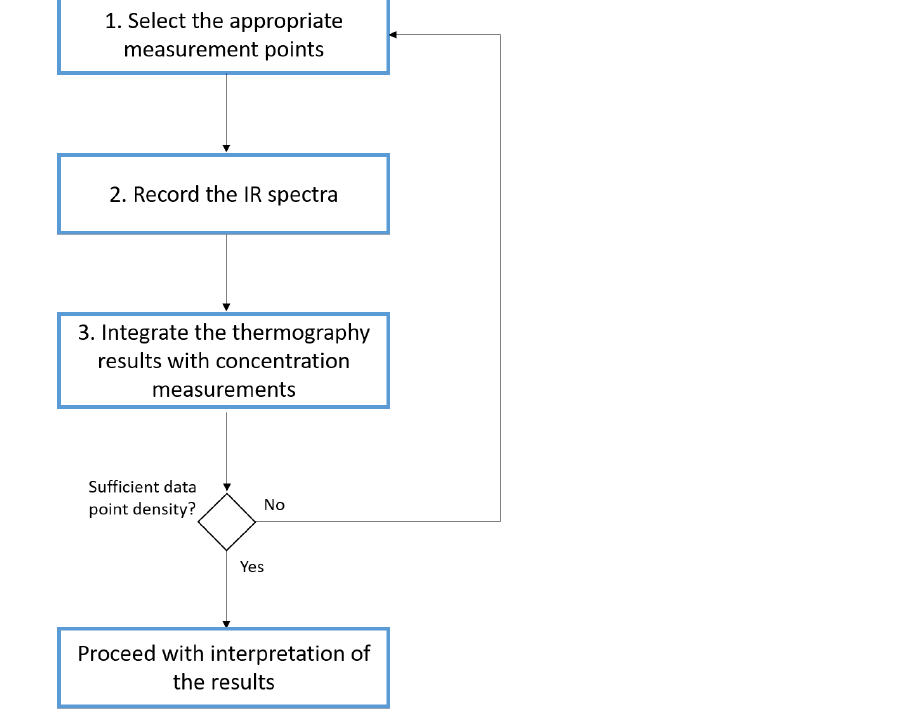
Figure 8. Suggested procedure for the data collection in IR thermography experiments. As a first step ( 1 ) the appropriate sequence and localization of the measurement points must be selected, to avoid misinterpretation of the thermographs. Later on ( 2 ), the IR spectra can be recorded and integrated ( 3 ) with appropriate concentration measurements, which must have a sufficiently high time resolution. The coupling of IR thermography and high frequency concentration measurements is essential to fully characterize the reactive